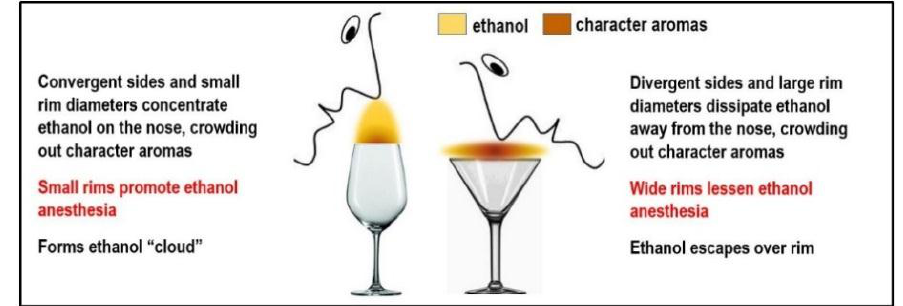
Figure 4. Small convergent rims contribute to ethanol anesthesia. Note “cloud” shapes over vessel rims. Extensive experimentation by Mitsubayashi et al. [16], using an infrared “sniffer-camera” to photograph ethanol cloud shapes created by different vessel shapes through a catalytic coated mesh validates the ethanol evaporation patterns shown. Prior to Mitsubayashi, cloud shapes could not be imaged, since infrared does not detect ethanol. Previous cloud “boundaries” were empirically determined by careful nosing.